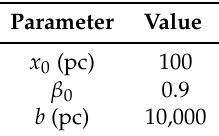
Figure 7. Numerical relativistic solution as given by Equation (51) (full line) and truncated series expansion as given by Equation (7) (dashed line), with parameters as in Table 2. Table 2. Parameters for a relativistic extra-galactic